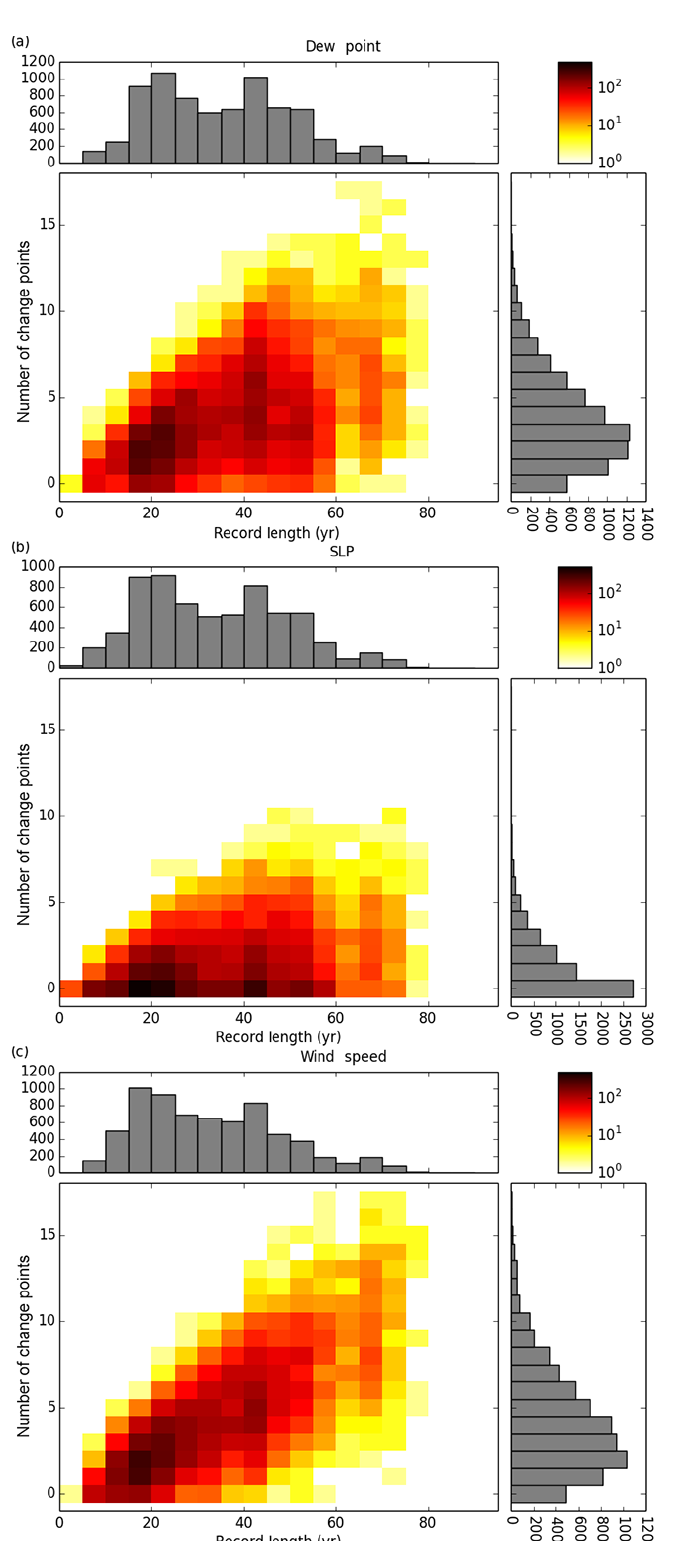
Figure A3. The distribution of stations with numbers of change points and record length for dew point, SLP and wind speed. Histograms show the distribution of stations with record length (above panels) and with change point number (right panels), which are the projections onto the x and y axes of the main panel respectively. The colour bar (top right panel) is on a logarithmic scale.